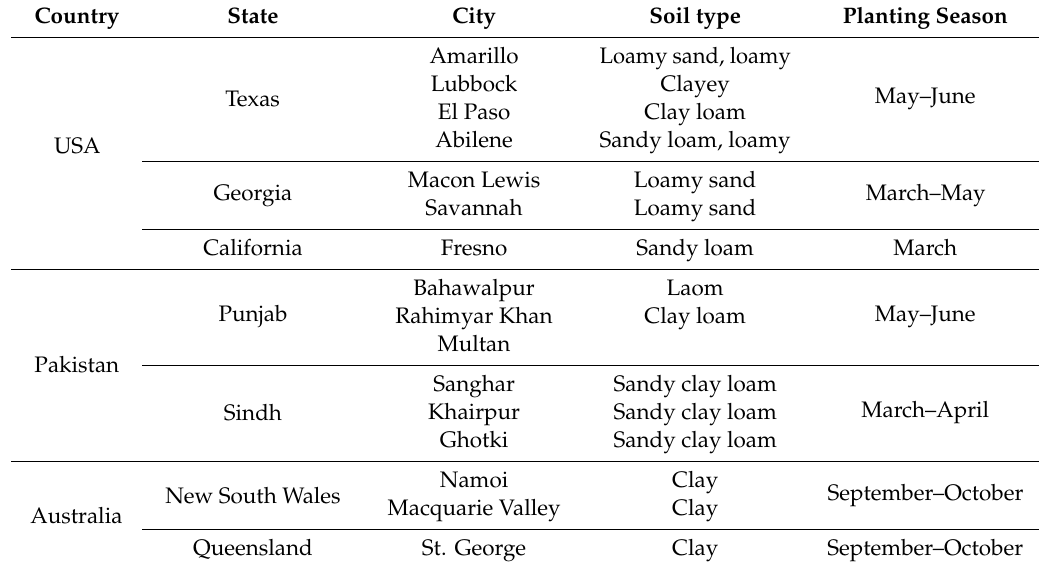
Table A13. Soil type and cotton planting season of di ff erent cotton producing states of USA, Pakistan,